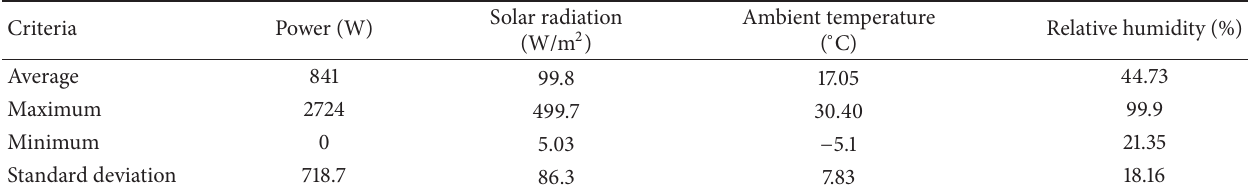
Table 1: The statistical classification of cloud database.